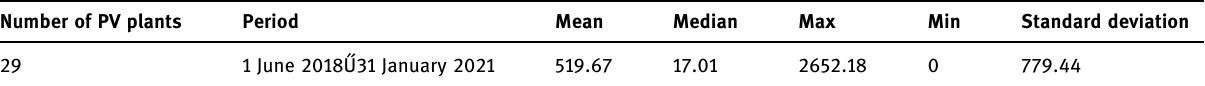
Table 2: Parameters of statistics for Yarmouk University PV solar power plant [ 14 ]